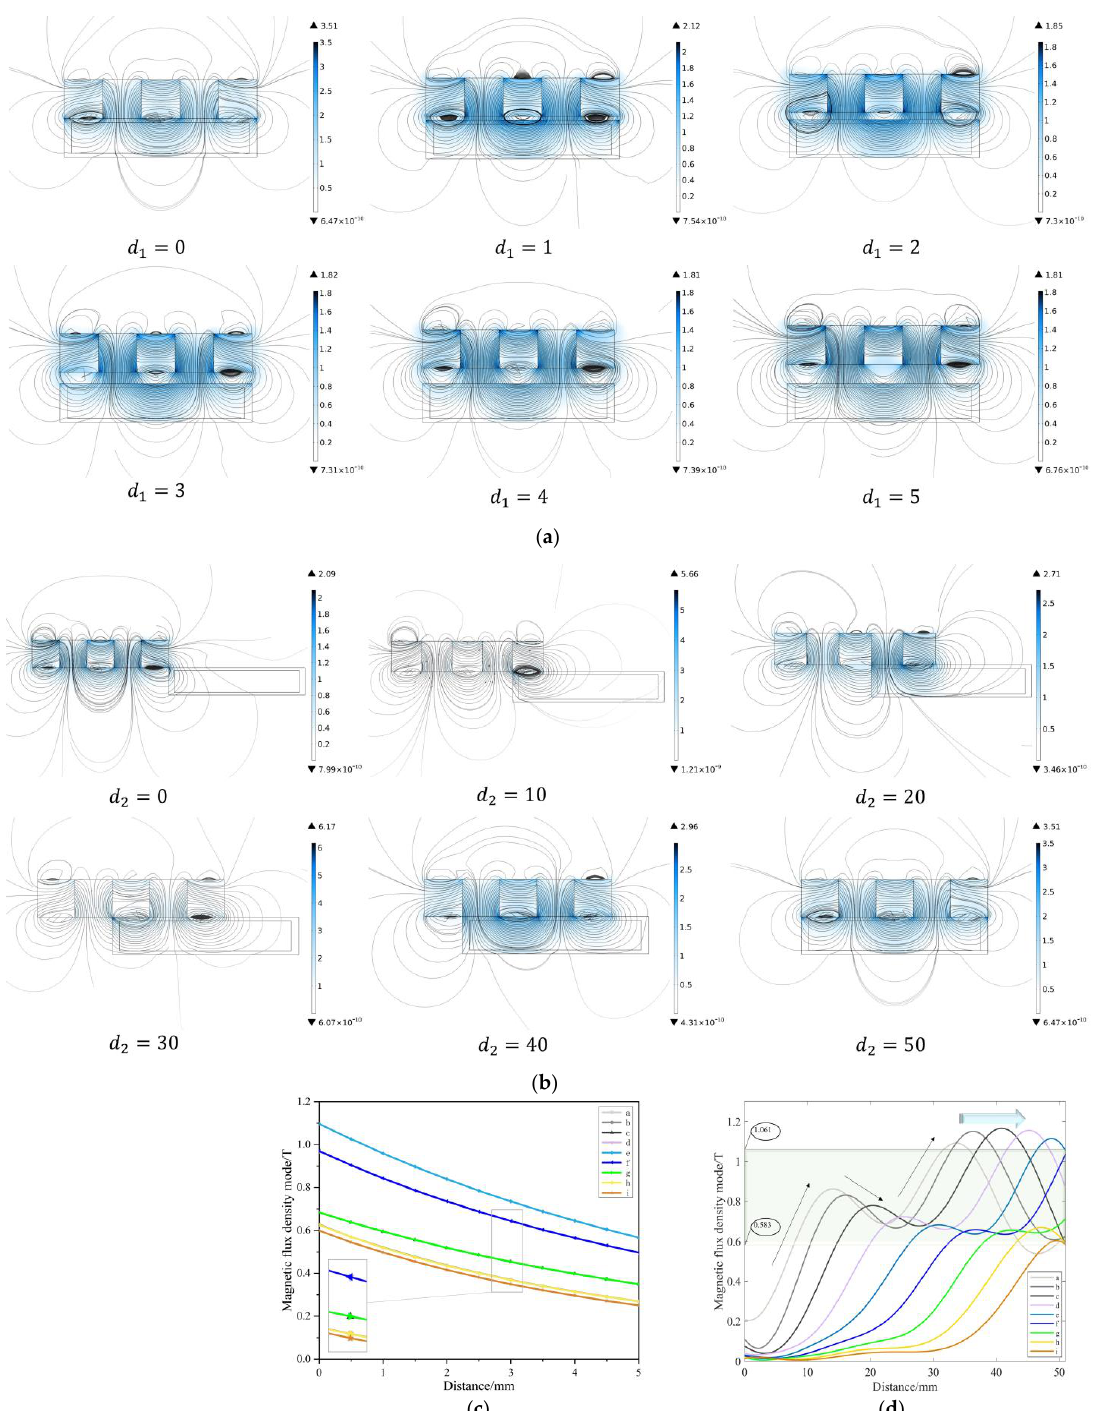
Figure 7. Schematic of Halbach array and MRG layer. ( a ) Longitudinal movement schematic; ( b ) Lateral movement schematic. Where the yellow arrow is the direction in which the Halbach array moves, 𝑑 1 is the longitudinal moving distance between the two and 𝑑 2 is the lateral moving dis- tance between the two. In order to make the magnetic field completely cover the MRG layer, the optimal position of the Halbach array needs to be determined. Therefore, the simulation analysis of the magnetic field strength at different distances is carried out for the lateral and longi- tudinal positions of the Halbach array and the MRG layer, respectively. The results of magnetic field simulations are shown in Figure 8.